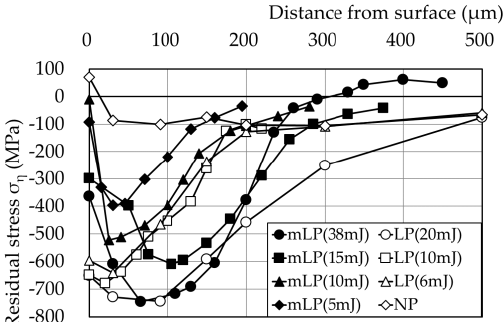
Figure 12. Comparison of residual stress depth distribution.